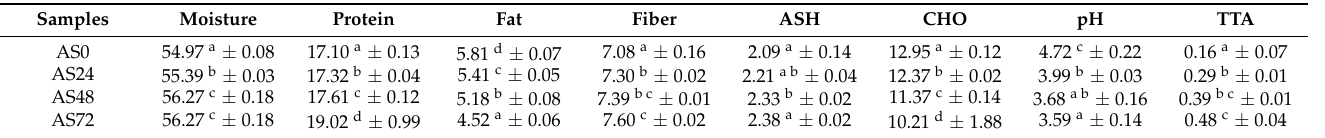
Table 1. Effect of fermentation (SSF) time on the proximate and physical composition (%) of the fermenting raw materials (wet